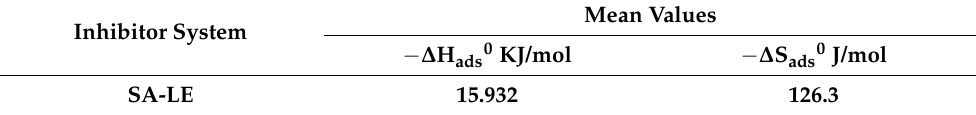
Figure 6. Plot of ∆ G 0 ads vs.T for mild steel in aqueous leaf extract of 10% SA at different temperatures. The mean values ∆ H 0 ads and ∆ S 0 ads in the temperature range 303–333 K, calculated using the Equation of Gibbs Helmholtz Equation are listed (Table 8). Table 8. ∆ H 0 ads and ∆ S 0 ads temperature range in 1.0 M HCl for SA leaf aqueous